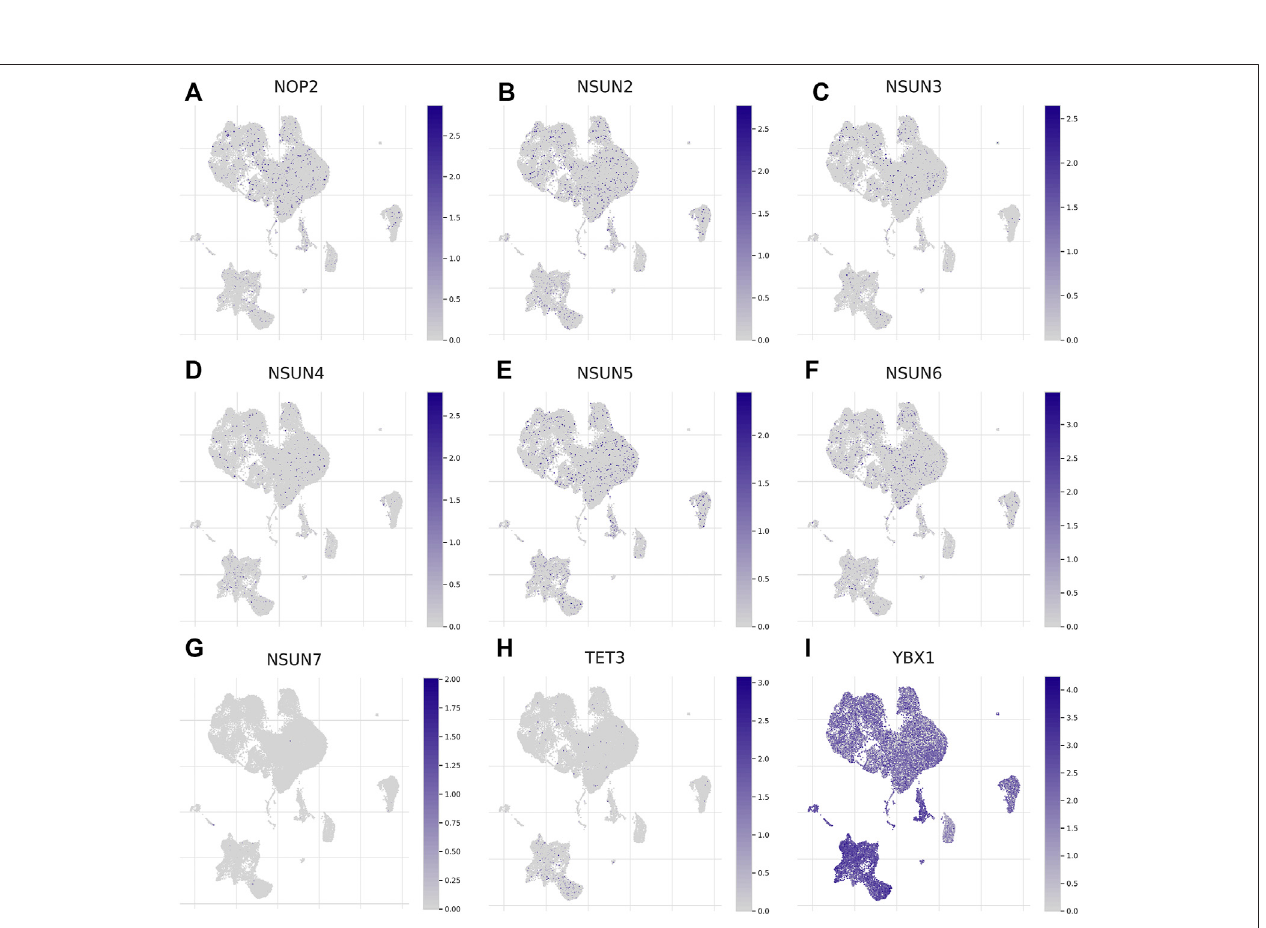
FIGURE 2 | Expression of m5C regulators in tumor microenvironment-related cells (TISCH). (A-I) The expression of m5C regulators in immune cells.